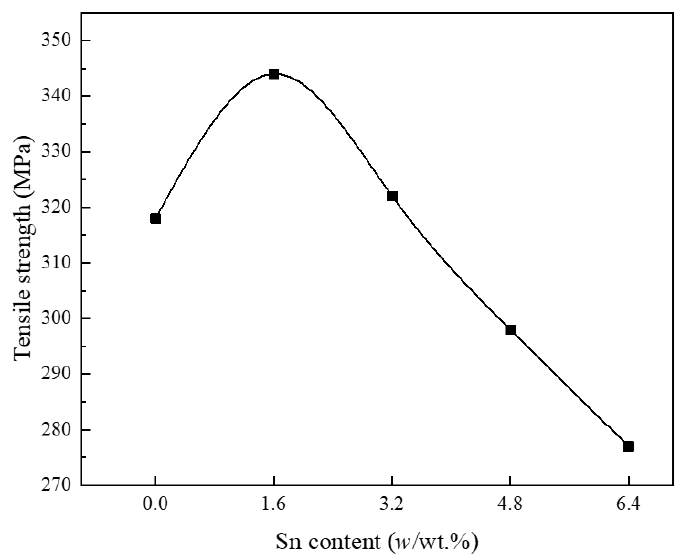
Figure 18. Tensile strengths of the Q235 carbon steel joints brazed using BCu68Zn filler metals with different contents of Sn [56].